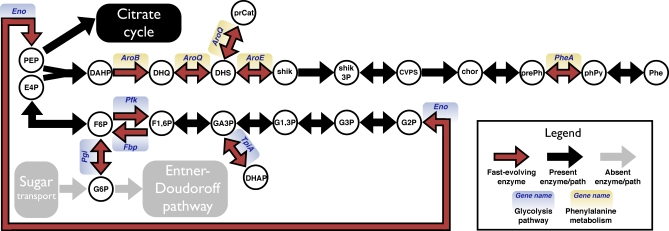
Rapidly Evolving Pathways in I. loihiensis
Simplified schematic of glycolysis and phenylalanine metabolism in I. loihiensis. Metabolic intermediates are denoted by white circles; enzymes by arrows. “Fast-evolving” enzymes, depicted as red arrows, are defined as those with ν in the top 10% of genes in the I. loihiensis genome. The names of genes encoding fast-evolving enzymes are shown, highlighted in light blue or orange, respectively for glycolysis or phenylalanine metabolism. Nonfunctional pathways (those with many key enzymes or transporters missing) are shown in gray. Of the “present” enzymes shown in black, only one is slow-evolving (ν < 1) in Idiomarina: COG 191, encoding the enzyme fructose bisphosphate aldolase, which interconverts F1,6P and GA3P. Abbreviations for metabolic intermediates: PEP, phoshphenolpyruvate; E4P, erythrose-4-phosphate; DAHP, 7P-2-dehydro-3-deoxy-arabinoheptonate; DHQ, 3-dehydroquinate; DHS, 3-dehydroshikimate; prCat, protocatechuate; shik, shikimate; shik-3P, shikimate-3-phosphate; CVPS, 5-O-(1-carboxyvinyl)-3-phosphoshikimate; chor, chorismate; prePh, prephenate; phPy, phenylpyruvate; Phe, phenylalanine; G6P, glucose-6-phosphate; F6P, fructose-6-phosphate; F1,6P, fructose-1,6-bisphosphate; GA3P, glyceraldehyde-3-phosphate; DHAP, dihydroxyacetone phosphate; G1,3P, glyerate-1,3-bisphospate; G3P, glycerate-3-phosphate; G2P, glycerate-2-phosphate. COG and EC numbers of fast-evolving genes: AroB: COG337, EC4.2.3.4; AroQ: COG757, EC4.2.1.10; AroE: COG169, EC1.1.1.25; PheA: COG77, EC4.2.1.51; Pgi: COG166, EC5.3.1.9; Fbp: COG158, EC3.1.3.11; Pfk: COG205, EC2.7.1.11; TpiA: COG149, EC5.3.1.1; Eno: COG148, EC4.2.1.11.